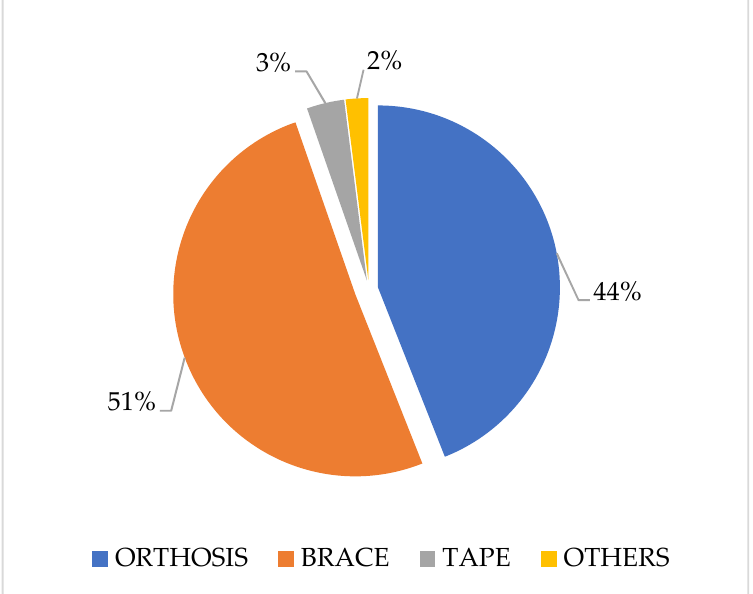
Figure 7. Type of ankle sprain prevention method.